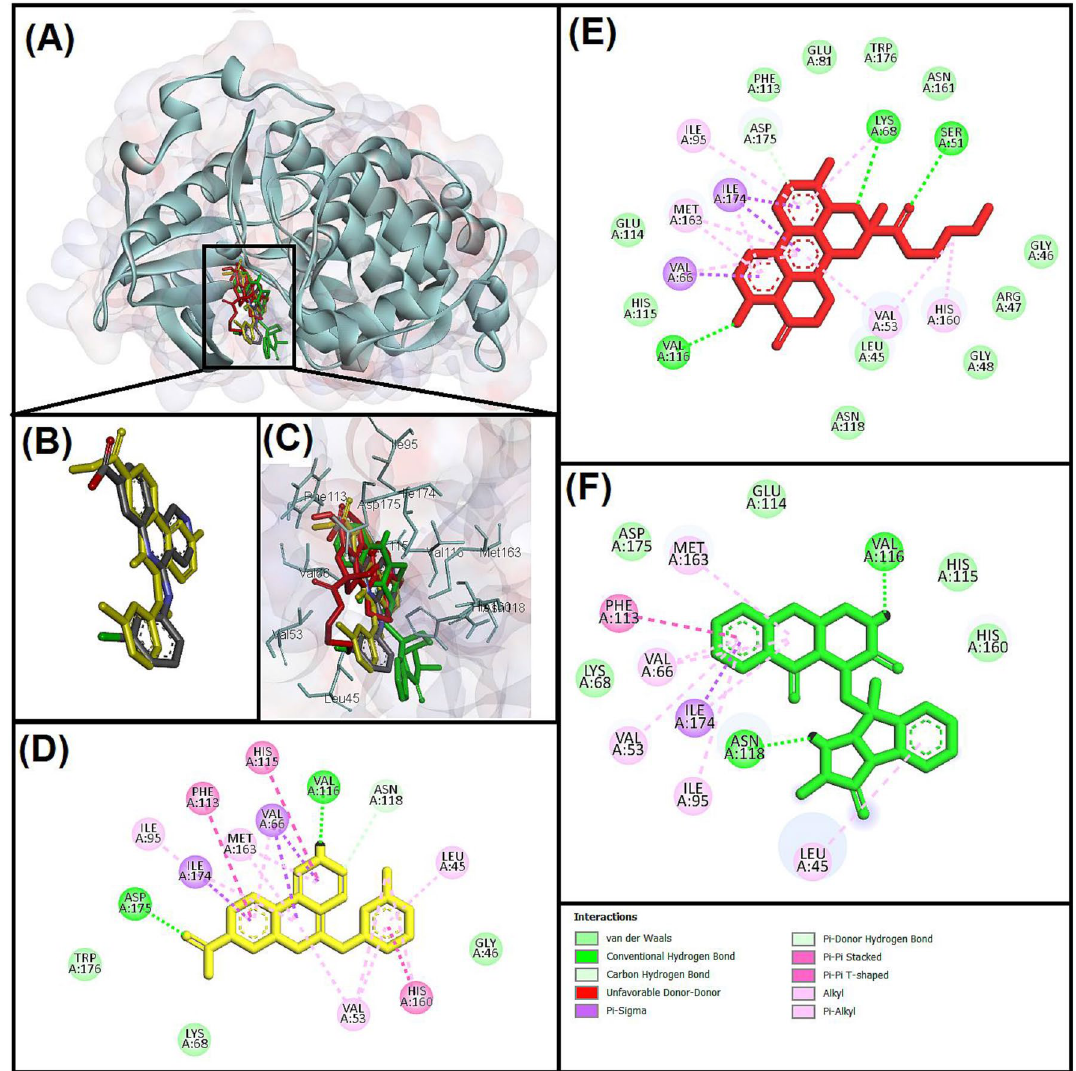
Figure 6. Molecular interactions analysis of best docked ligands with human protein kinase CK2α-subunit (3PE1) enzyme. ( A ) Superimpose image of docked ligands; ( B ) superimpose image of redocked (Yellow) and native (Grey) ligand; ( C ) zoom in image of all the docked ligands and interacting residues; two-dimensional structure and interacting residues of ( D ) CX-4945 (redocked), ( E ) Butyl Xanalterate (Red), ( F ) Fumiquinazoline Q